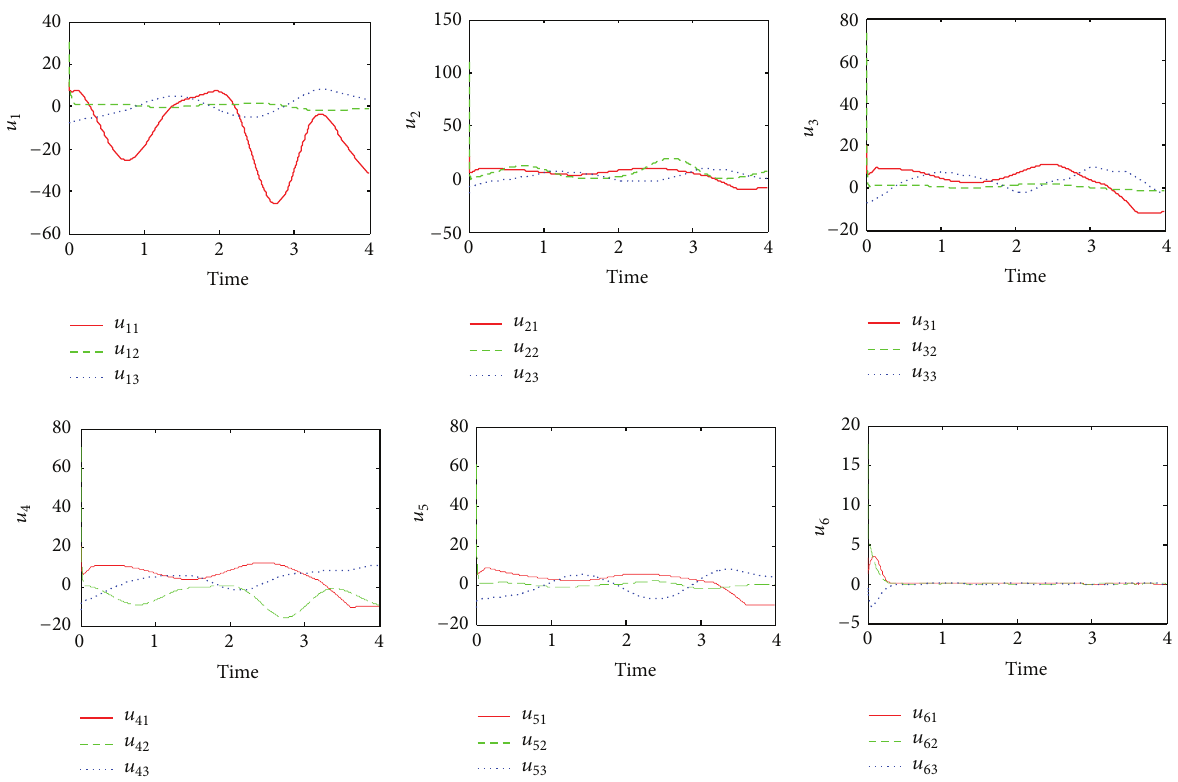
Figure 2: The curve of control 𝑢 𝑖 (𝑡) with 𝑖 = 1, ...,6